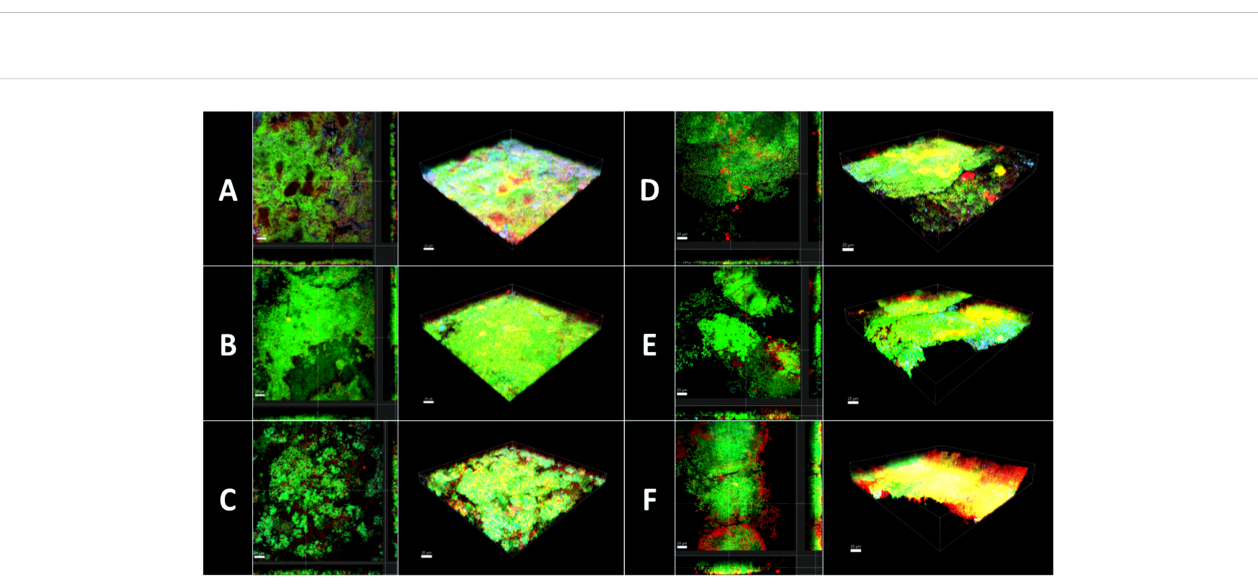
FIGURE 7 Confocal laser scanning microscopy (CLSM). 3D reconstructions and images sections of bio fi lm grown 3 days on HA discs and afterwards treated with different mouthrinse (A) 0.2% CHX, (B) 10% EtOH, (C) 0.9% NaCl, (D) Ratanhia, (E) Tebodont, (F) Trybol. The bio fi lms were used for viability analysis and visualization of extracellular DNA (eDNA): SYTO 40 a cell-permeant nucleic acid stain in green, DRAQ7 in red and TOTO-1 cell impermeable DNA dyes in